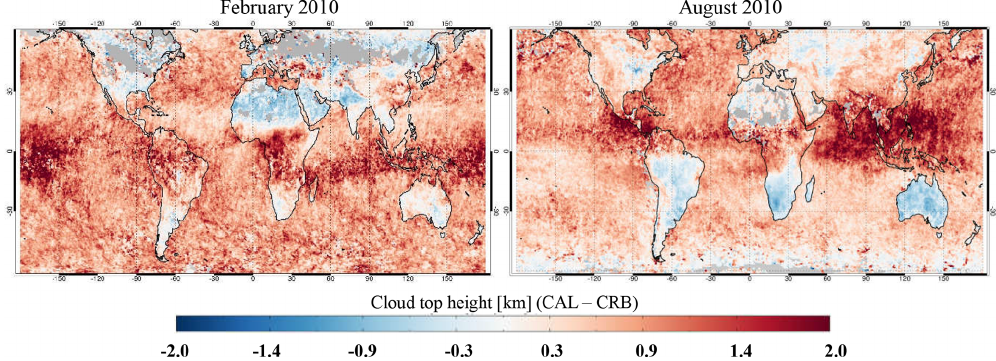
Figure 10. Differences in cloud top heights retrieved using the ROCINN_CAL and ROCINN_CRB cloud models in February and Au- gust 2010. Only measurements with a cloud fraction less than 0.3 are included. Observations with a fitting rms greater than 1 × 10 − 4 or a number of iterations greater than 20 are filtered